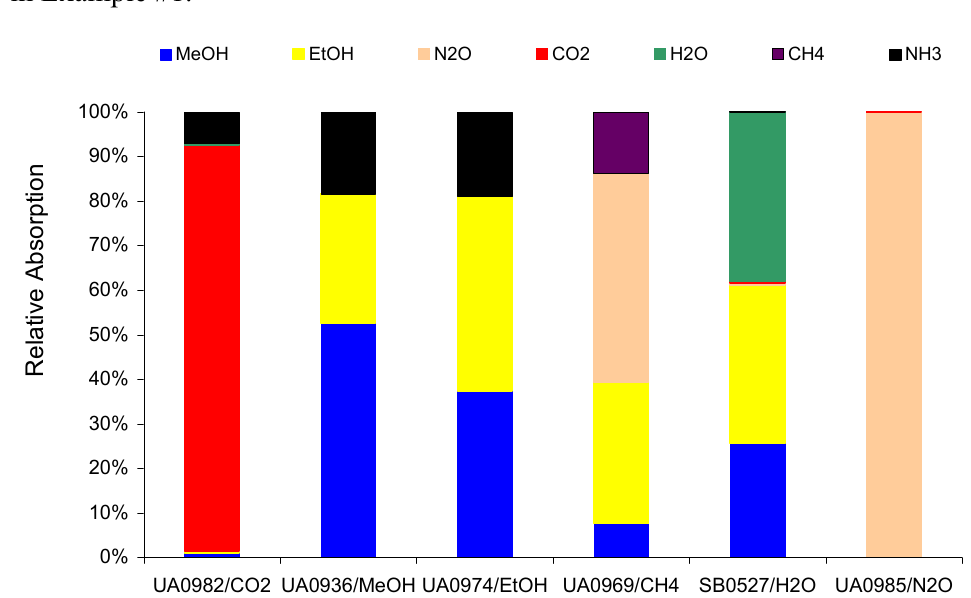
and 1 ppm target gases at each 3